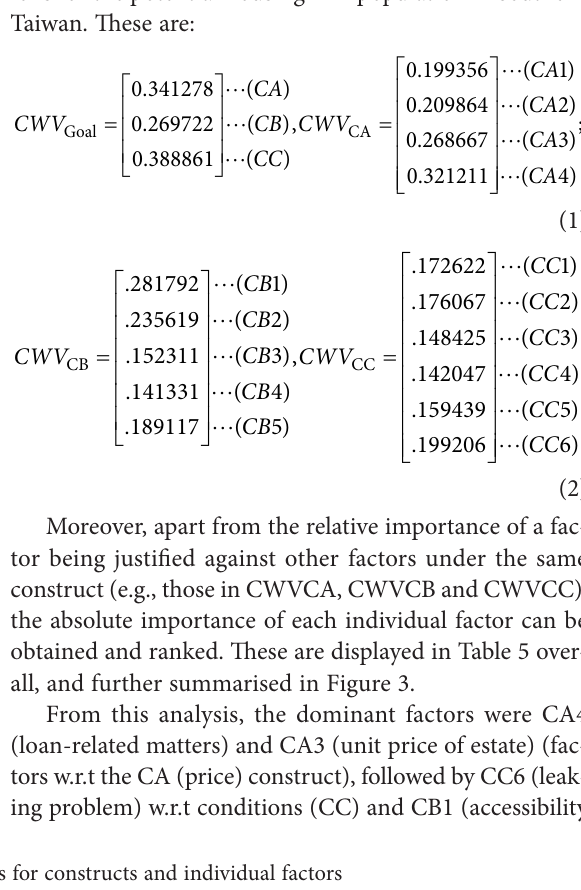
Table 5. Local ranks and absolute weights for constructs and individual